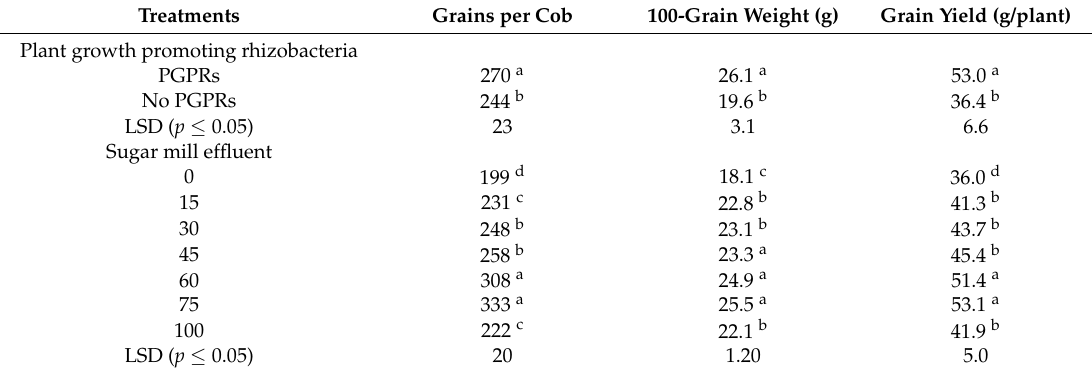
Table 3. Influence of diluted sugar mill effluent and PGPR on number of grains per cob, 100-grain weight and grain yield of maize. Treatments Grains per Cob 100-Grain Weight (g) Grain Yield (g/plant) Plant growth promoting rhizobacteria